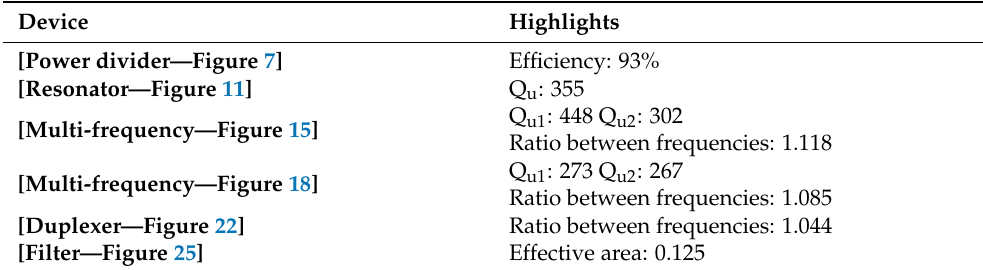
Table 2. Summary of the relevant